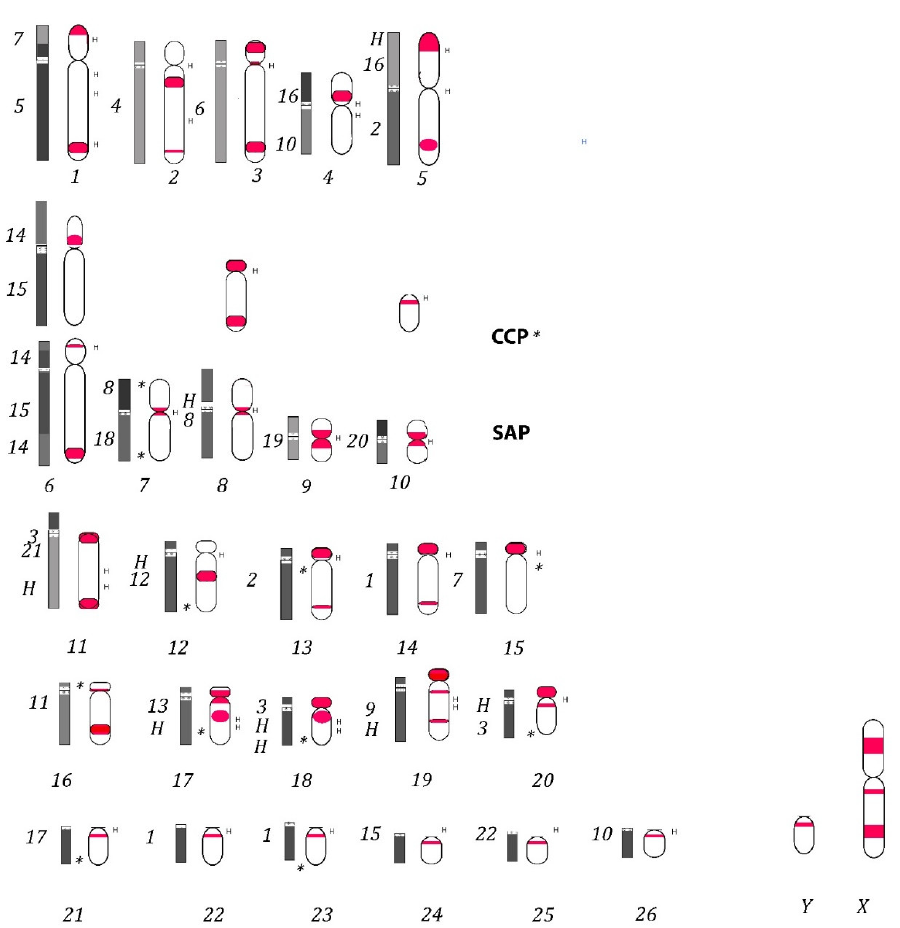
Figure 3. Haploid ideograms for the two species: S. apella and C. capucinus (SAP and CCP), with LINE-1 signals in red. Note chromosome pairs 6, 8, and 10 are different due to inversions between the species (CCP chromosomes 6, 8, and 10 forms are reported above the line); additional signals are indicated with an asterisk for CCP *. The human syntenies as well as constitutional hetero- chromatin–H extrapolated from previous painting data are reported at the left of chromosomes with numbers and bars [35–37]; different human associations on the same chromosomes are re- ported on bars also with grey or black colors. At the right of each ideogram the H indicates C- bands here obtained. Chromosomes 17 and 18, apart from a different LINE-1 signal pattern, have a slightly different C banding, not reported here (see also Figure 2). Homologies with human syntenies were taken into account by extrapolating data from painting results for karyotypes of C. capucinus and S. apella [35–37] (Figure 3). LINE-1 probe signals on human metaphases (Figure 1c) were depicted on the hu- man DAPI inverted karyotype (Supplementary Figure S1). LINE-1 probes showed bright signals especially prominent at the centromere of chromosome pair 8 and along chro- mosome 1 and X, and slight signals showed on chromosome pairs 9 and 13–15. Signals have been reported analysing more metaphases because some signals are not always evident.